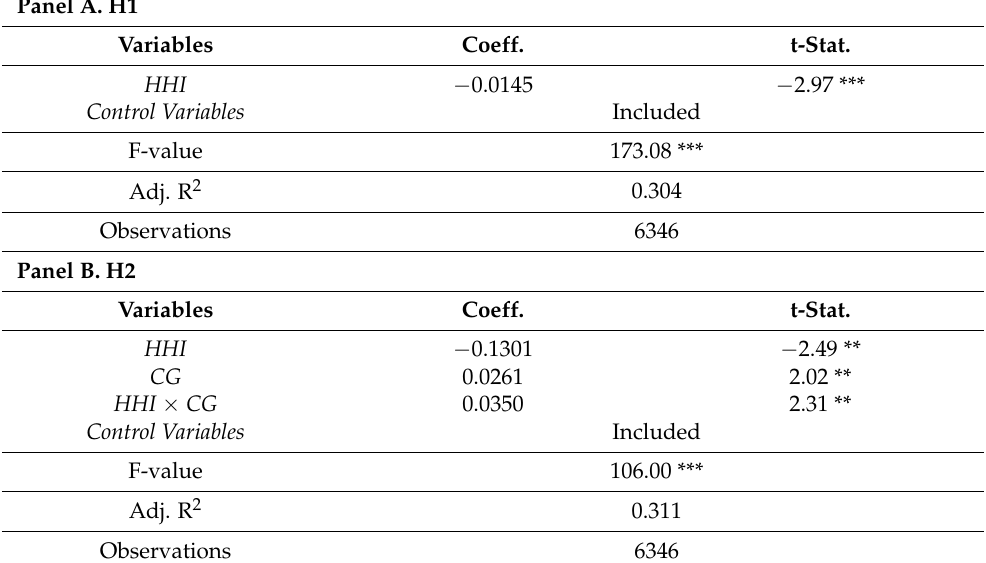
Table 7. Robustness